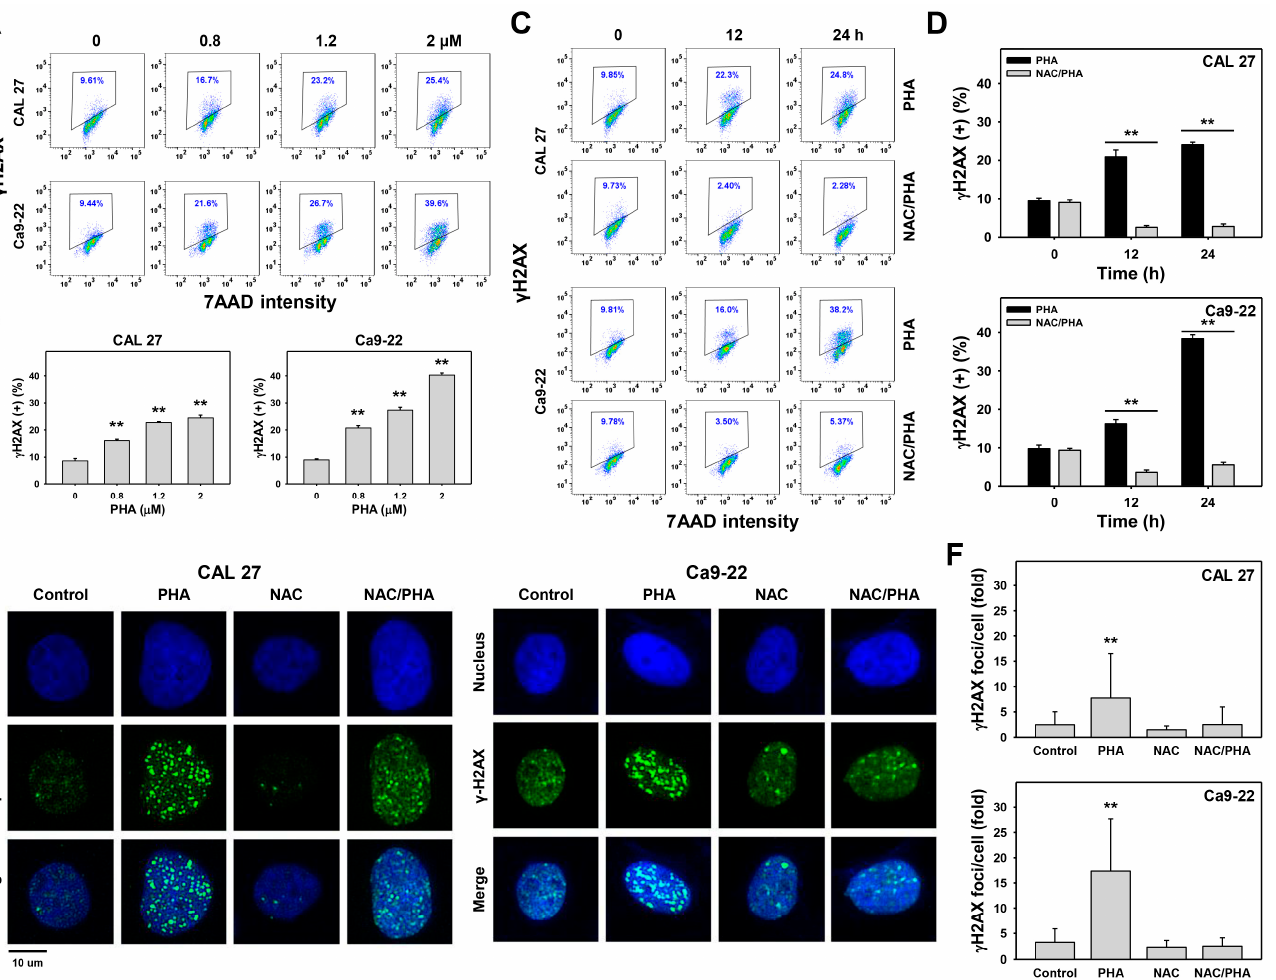
Figure 8. PHA promotes γ H2AX intensity and foci number in oral cancer cells. ( A , B ) γ H2AX analysis. Cells were exposed to 0 (0.1% DMSO medium as control), 0.8, 1.2, and 2 µ M PHA for 24 h. (+) population was counted for γ H2AX (+) (%). ( C , D ) Suppression of PHA-induced γ H2AX by NAC. To evaluate the recovery effect of NAC, NAC (10 mM for 1 h) was added to cells before 12 and 24 h treatment with PHA (control (0.1% DMSO medium) and 2 μ M), i.e., NAC/PHA. Data, means ± SDs ( n = 3 independent experiments). ( E , F ) γ -H2AX foci analysis. Cells were immunostained by γ H2AX primary antibody/Alexa Fluor 488-conjugated secondary antibody and counterstained with Hoechst 33342. γ H2AX foci were counted as foci per cell. Slides were photographed at 400 × magnification. Data, means ± SDs ( n = 30 cells); ** indicates p < 0.001. Moreover, γ H2AX flow cytometry expression was further validated by γ H2AX foci immunofluorescence (Figure 8E). The population for γ H2AX foci was higher in PHA-